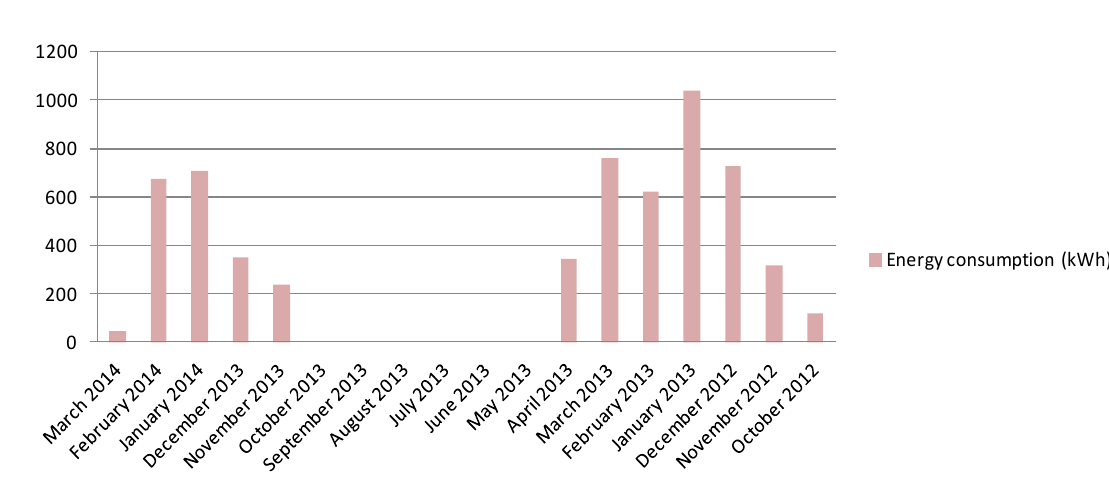
Figure 4. Energy consumption (kWh) in the same